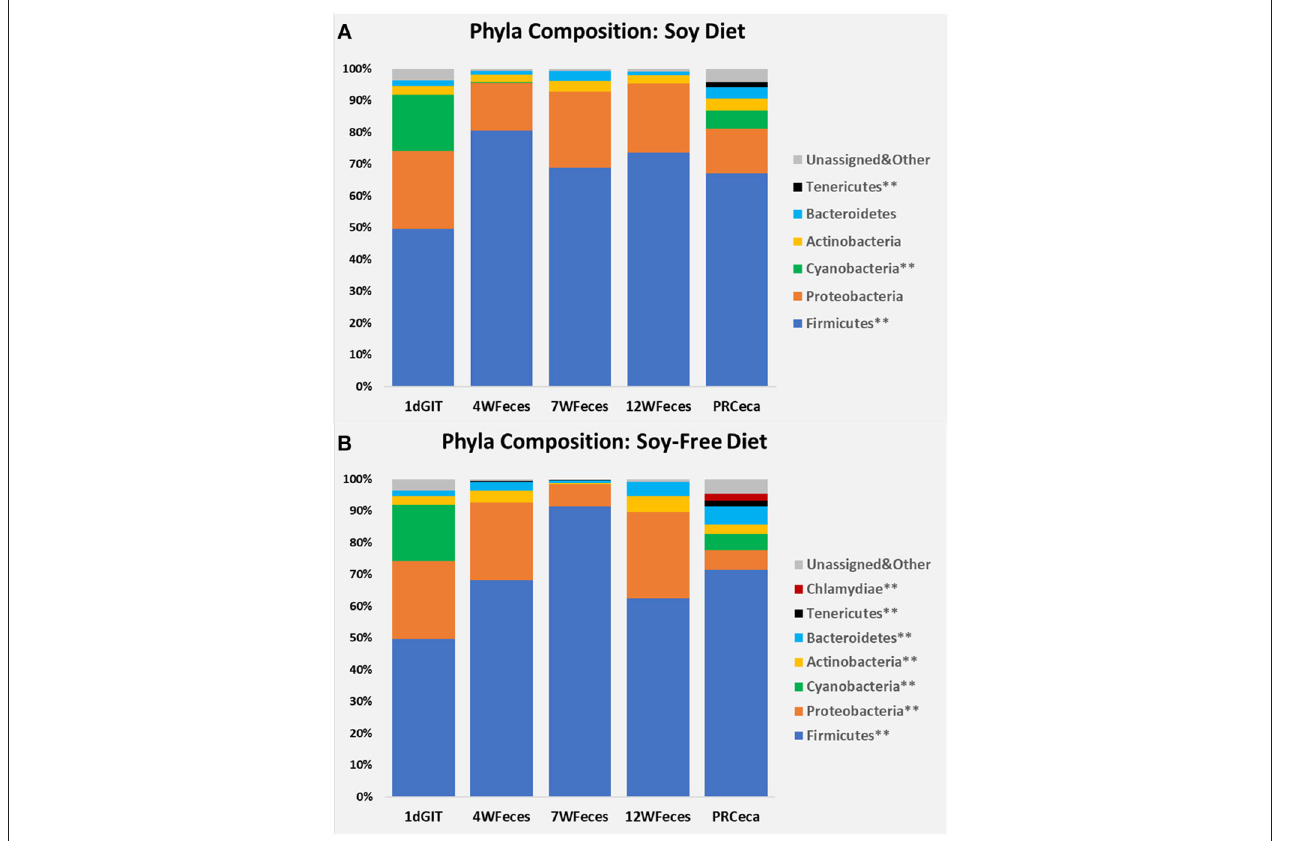
FIGURE 3 | Bacterial phyla composition of pasture-raised chicken over different stages of their lives: 1dGIT, Gastrointestinal contents from 1-day-old broilers; 4WFeces, Feces from 4-week-old broilers; 7WFeces, Feces from 7-week-old broilers; 12WFeces, Feces from 12-week-old broilers; PRCeca, Cecal contents collected during slaughter. (A) Broilers fed a soy-containing diet; (B) Broilers fed a soy-free diet.** Indicates that there were differences ( P ≤ 0.05) across the different sample types for the bacterial group (within the same